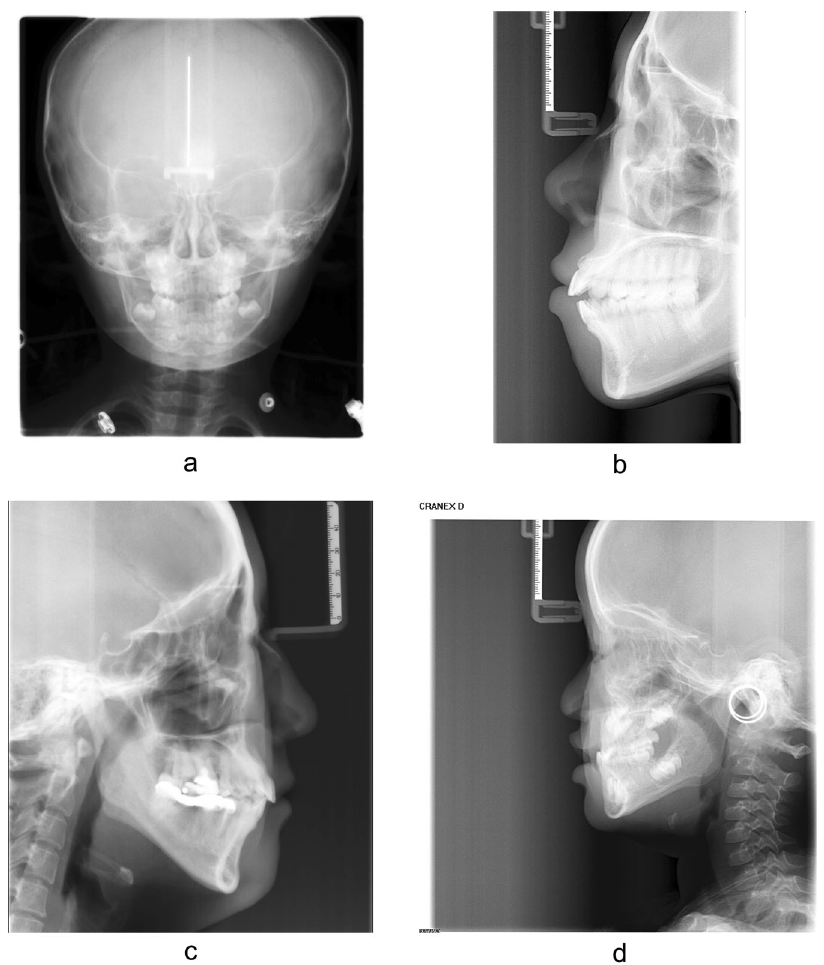
Fig. 9 Examples of some typical unquali fi ed images. a The actual age of the subject is less than 4 years or greater than 40 years. b Incomplete LCR image. c Subject with restorations in the teeth. d Incorrect imaging